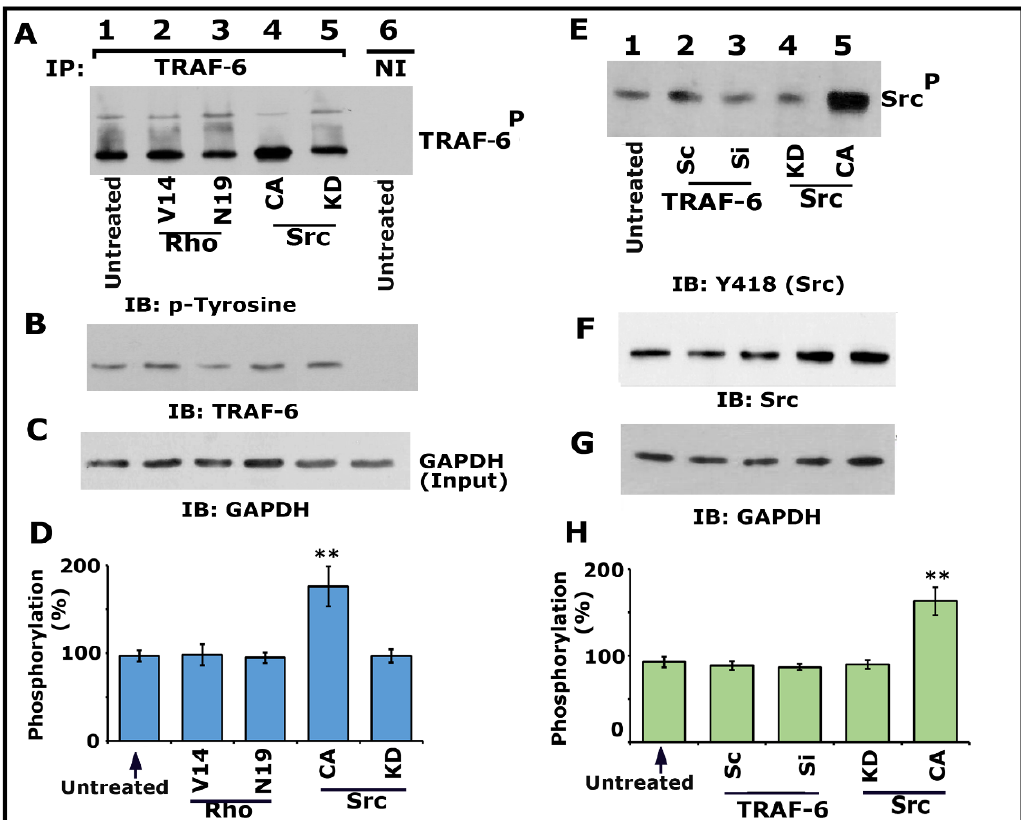
Figure 4. Immunoblotting IIB) analysis of phosphorylation of TRAF-6 and Src kinase on Y418. Osteoclasts untreated and treated with indicated treatments were incubated with TNF- α and bone particles for 3–4 h. ( A – D ) Lysates made from osteoclasts untreated (lanes 1 and 6) and either transduced with TAT-Rho proteins (V14 and N19; lanes 2 and 3) or transfected with Src Ad-Src constructs (CA and KD; lanes 4 and 5) were immunoprecipitated with a TRAF-6 antibody or nonimmune serum (NI; lane 6). IB was performed with a p-tyrosine antibody ( A ). The blot was stripped and immunoblotted with an antibody to TRAF-6 to determine the immunoprecipitated levels of TRAF-6 ( B ). Lastly, direct immunoblotting of the lysates with a GAPDH antibody in panel C demonstrates the equal amount of total protein (Input) was used for immunoprecipitation with TRAF-6 ( C ). Percent phosphorylation of TRAF-6 is provided as a graph ( D ). ** p < 0.01 versus untreated osteoclasts. Values are the mean ± SEM of three different immunoblots. ( E – H ) Lysates made from these osteoclasts treated as indicated in panel E were immunoblotted with an antibody to Tyrosine 418 (Src) ( E ). The blot was stripped in sequence and immunoblotted respectively with an Src and then with a GAPDH antibody as loading controls for the result shown in panel E. The resulting pTRAF-6/TRAF-6 ratio was used for the quantitative analyses. ** p < 0.01 versus untreated osteoclasts. Results represent one of the three experiments with similar findings. Uncropped images are provided in the Supplementary